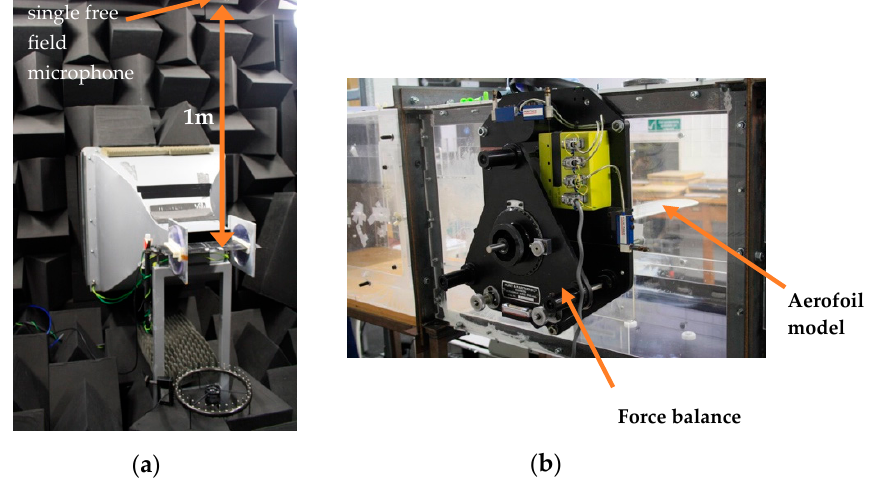
Figure 1. ( a ) Typical set up for the aerofoil noise experiments at the Brunel aeroacoustics wind tunnel for the turbulence–leading edge interaction noise; ( b ) load cell system used for the lift/drag measurements in a closed-section aerodynamic wind tunnel.